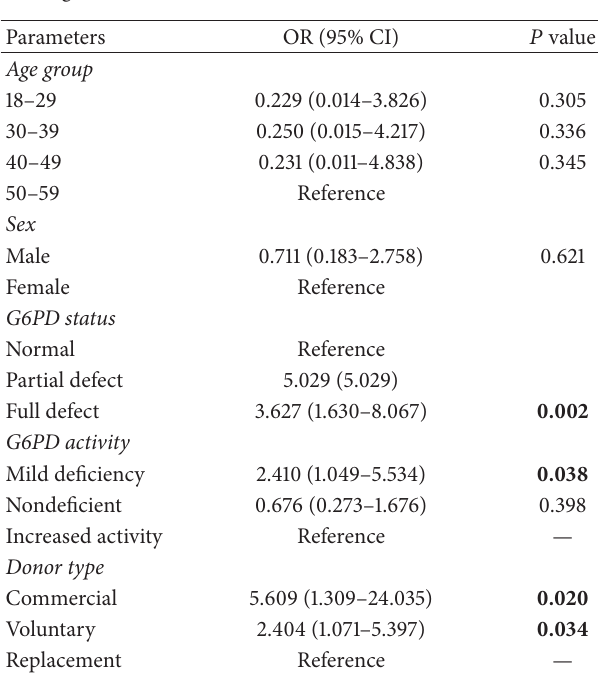
Table 6: Logistic regression of factors associated with sickle haemoglobin variant